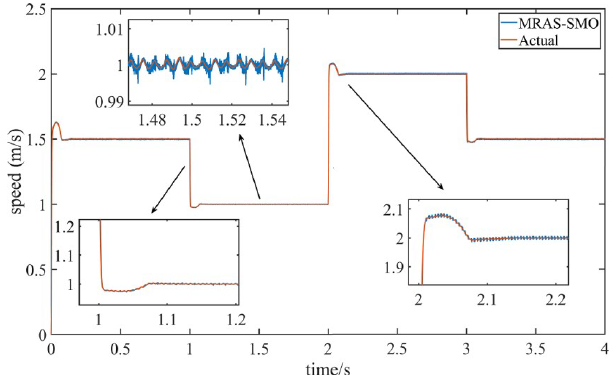
Figure 7. Variable load motion test of two controllers.